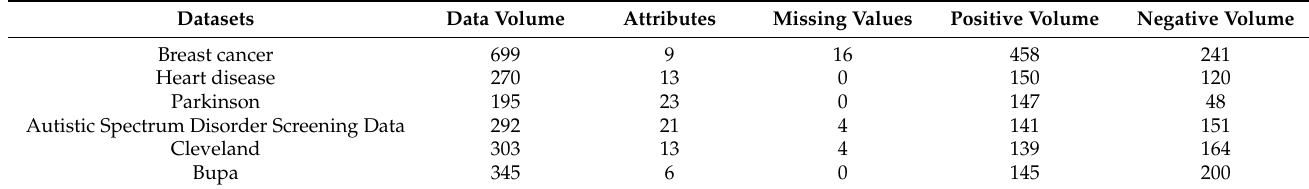
Table 1. The characteristics of the six disease